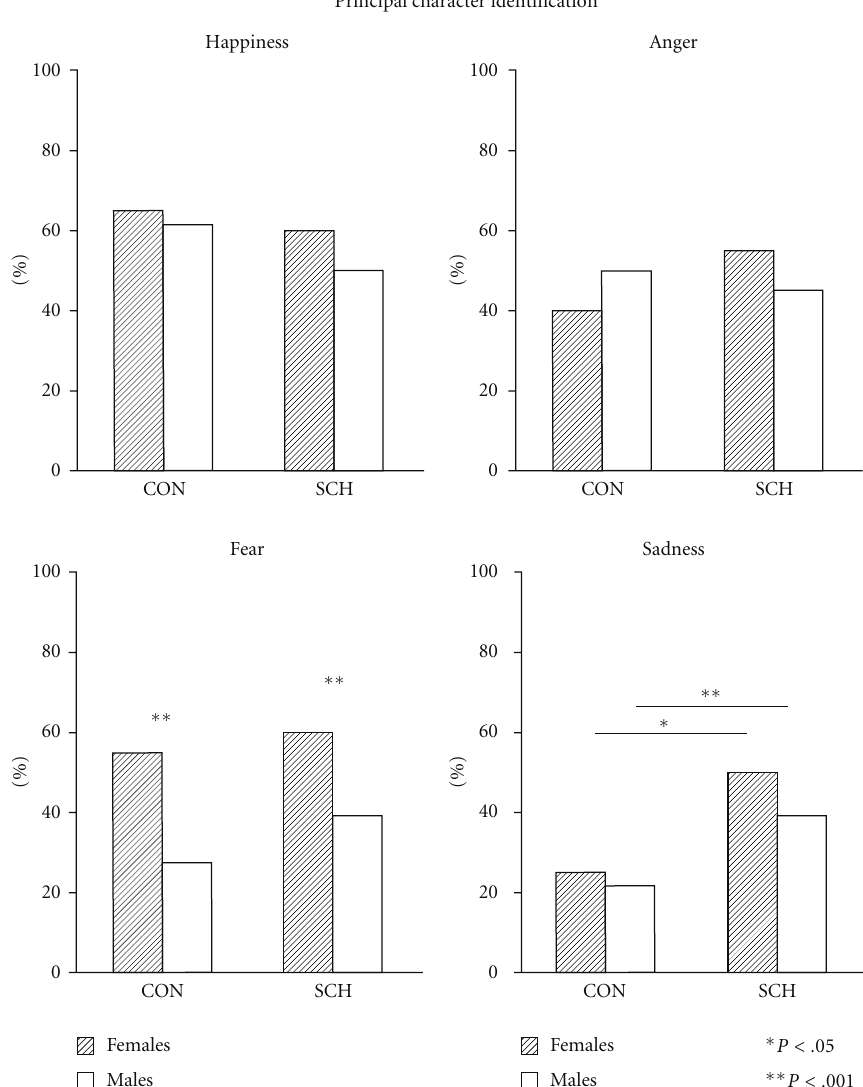
Figure 5: Percentage of controls (CON) and schizophrenic patients (SCH) that reported being identified with the principal